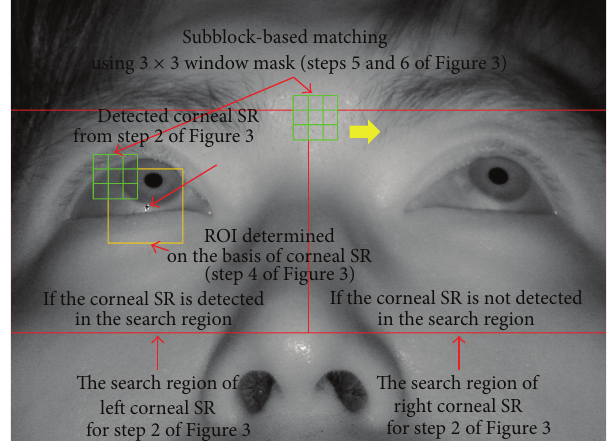
Figure 5: Sample detection of the corneal SR and approximate pupil